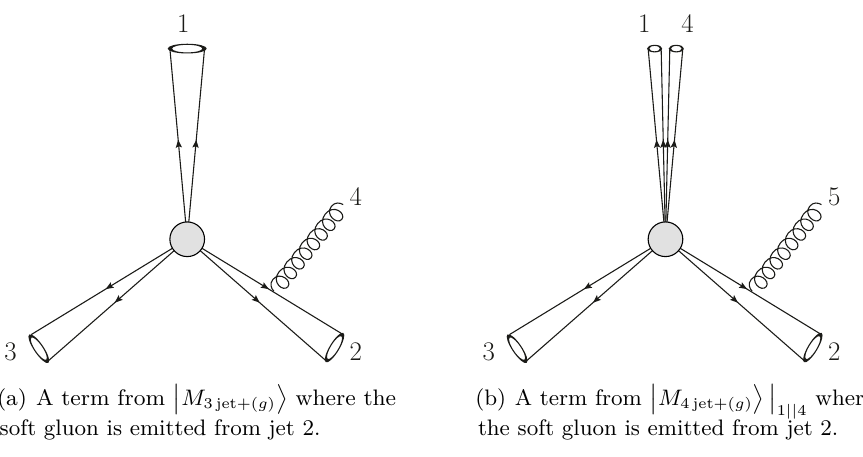
(cid:12) (cid:12) (cid:11) (cid:11) (cid:12) and . Cones represent jets of collinear (cid:12) M 3jet+( g ) (cid:12) M 4jet+( g ) (cid:12) 1 || 4